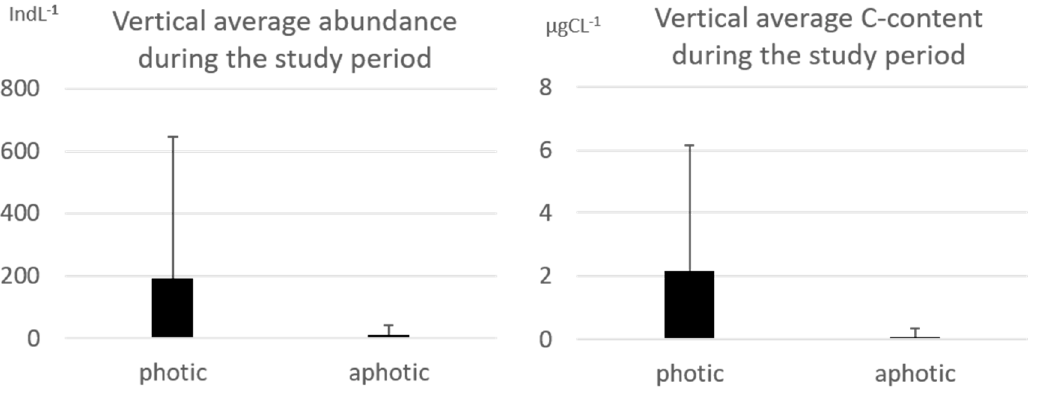
Figure 3. Average abundance of tintinnids (indL − 1 ) and average tintinnids carbon content ( µ gCL − 1 ) in the study area detected in the totality of the photic zone (photic < 200 m) and in the aphotic zone (aphotic ≥ 200 m); bars represent standard deviation ( sd ); photic n = 272, aphotic n =